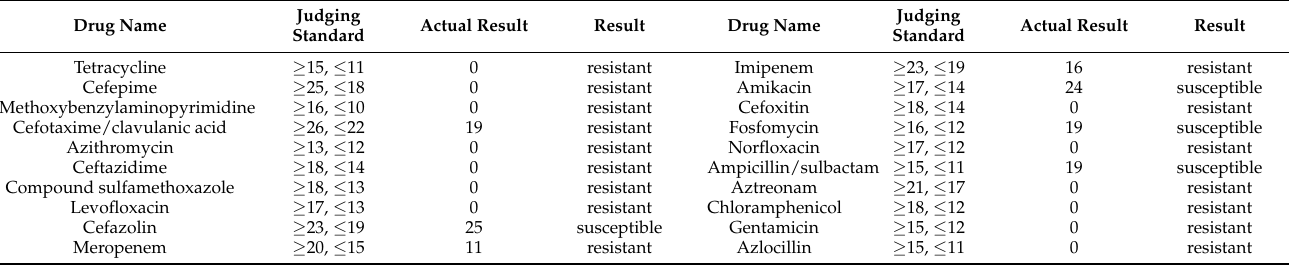
Table 2. Results of the drug sensitivity